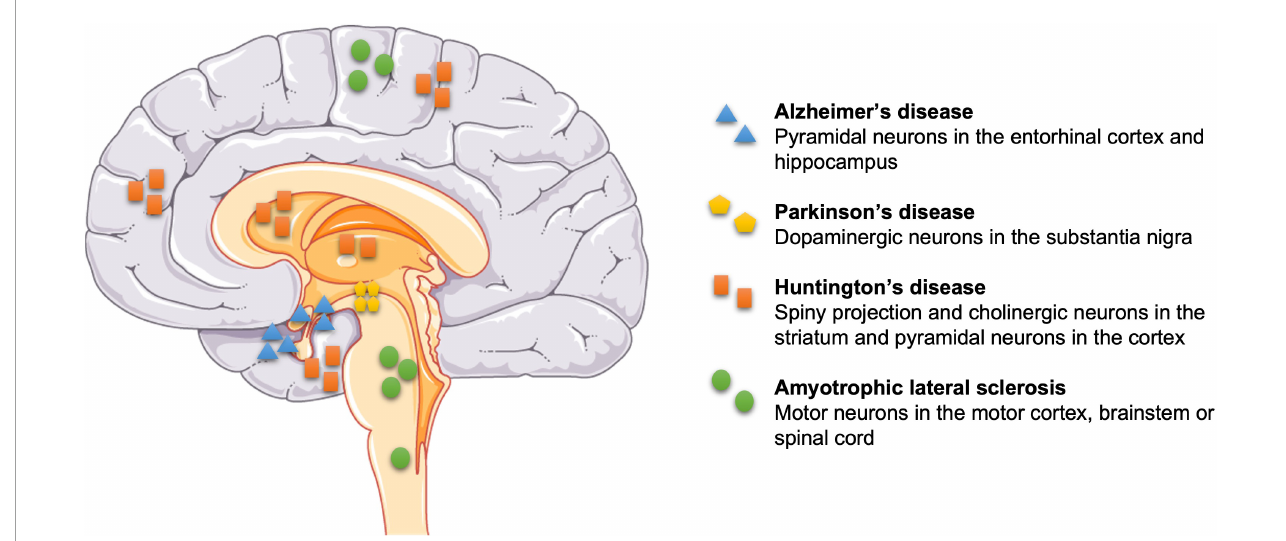
FIGURE1 Selective sites of neuronal death in some neurodegenerative diseases. Pyramidal neurons in the entorhinal cortex layer II and hippocampus layer CA1 in Alzheimer’s disease (AD), dopaminergic neurons in the substantia nigra pars compacta in Parkinson’s disease (PD), GABAergic spiny projection and cholinergic neurons in the striatum, and pyramidal neurons in the cortex in Huntington’s disease (HD), and motor neurons in the motor cortex, brainstem or spinal cord in amyotrophic lateral sclerosis (ALS).